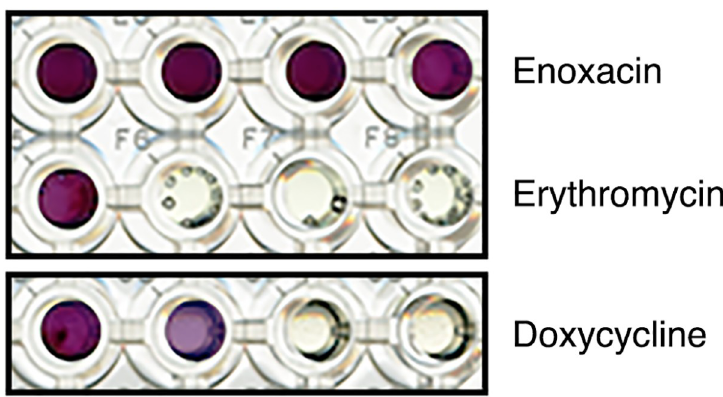
Fig 1. Examples of growth in Phenotype Microarray plates. The growth of S . aureus ATCC 25923 in four wells of increasing enoxacin, erythromycin and doxycycline concentrations is shown. The intensity of colour development (due to the presence of a redox dye) was scored by eye, 24 h after inoculation. It was scored as either 0 (no growth), 1 (intermediate growth) or 2 (full growth). Summing the growth in all four wells yielded a score out of 8 for each antimicrobial. In the examples shown, growths scores of 8, 2 and 3 were recorded for enoxacin, erythromycin and doxycycline, respectively.